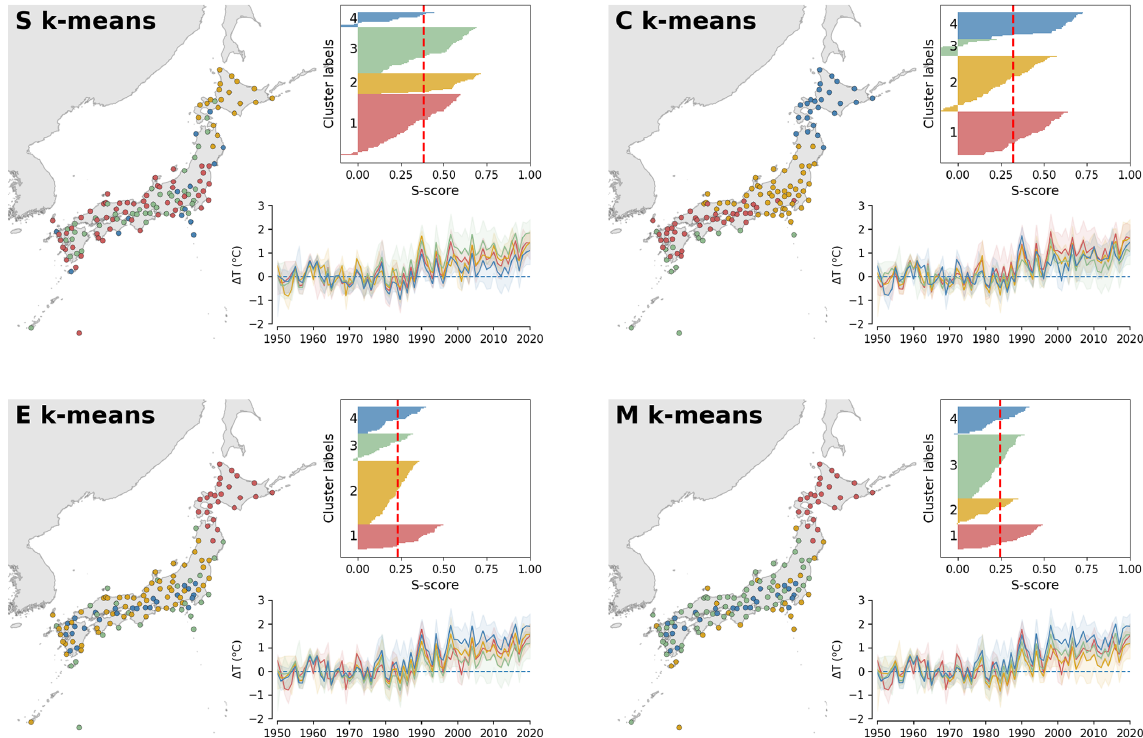
Figure 4. Result for the CC experiment for clustering of climate change (temperature increase) time series over 134 weather stations over the entirety of Japan. Patterns were revealed by S, C, E, and M k -means, with k = 4. Input data correspond to annual-mean data collected over 70 years from 1951–2020 (subtracted by the mean of the first 30 years) and observed temperature achieved at in situ weather stations (dots on map) operated by the JMA. Time series of centroids and input vectors are shown in the bottom panels together with general silhouette analysis results, where the x axis indicates the score (S score), and the y axis presents the labels of clusters numbered